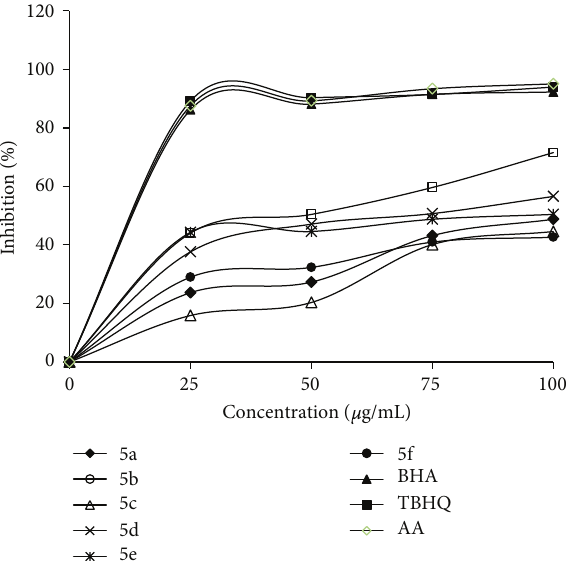
F 6: Metal-chelating activity of compounds ( 5 ).